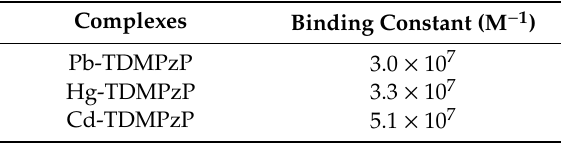
Table 4. Binding constants of M-TDMPzP